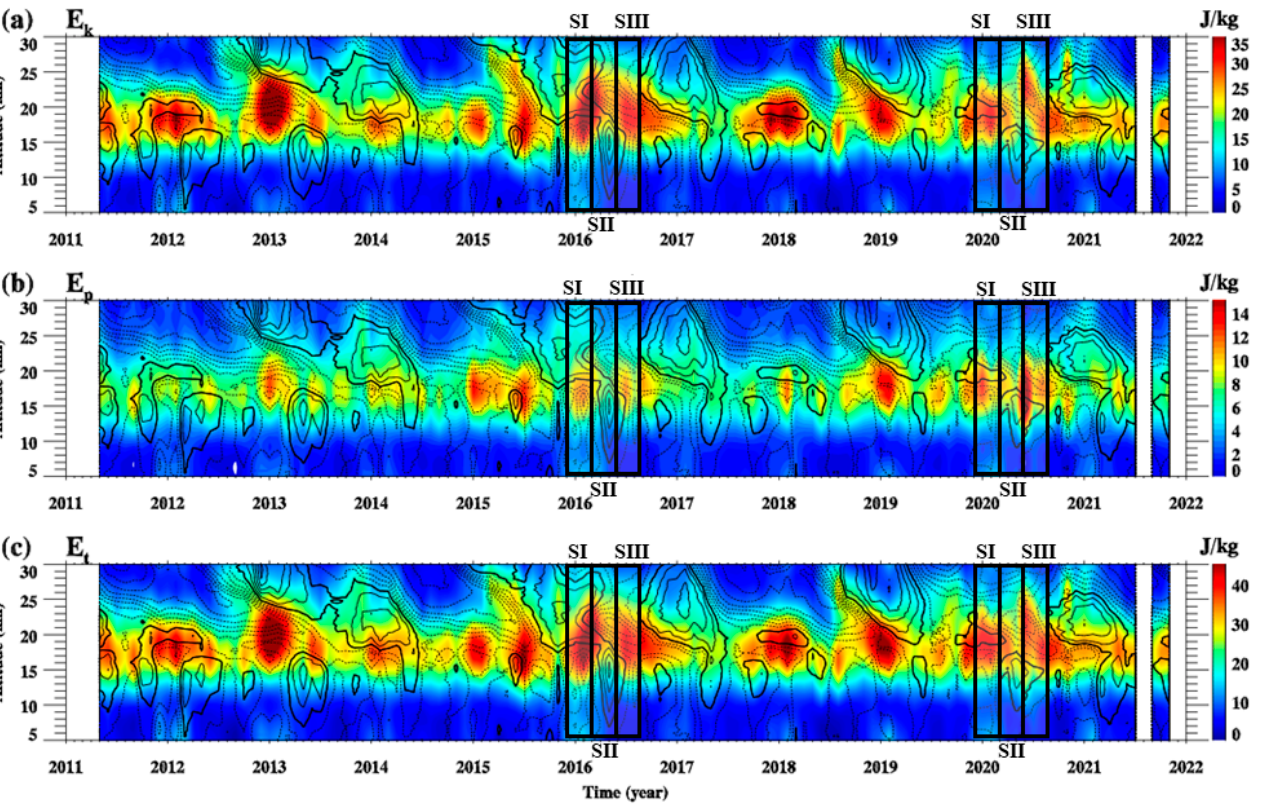
Figure 2. Altitude and temporal variations in monthly mean gravity wave ( a ) kinetic energy density (in J/kg), ( b ) potential energy density (in J/kg), and ( c ) total energy density (in J/kg) over Ponape Island (6.97°N, 158.22°E). The monthly mean zonal wind is overplotted in black contours with a contour interval of 5 m/s. The solid and dashed contours denote the westward and eastward zonal winds, respectively. The thick contours represent zero zonal wind. The blanks represent no observational data. Boxes indicate SI, SII, and SIII stages in panels ( a – c ).